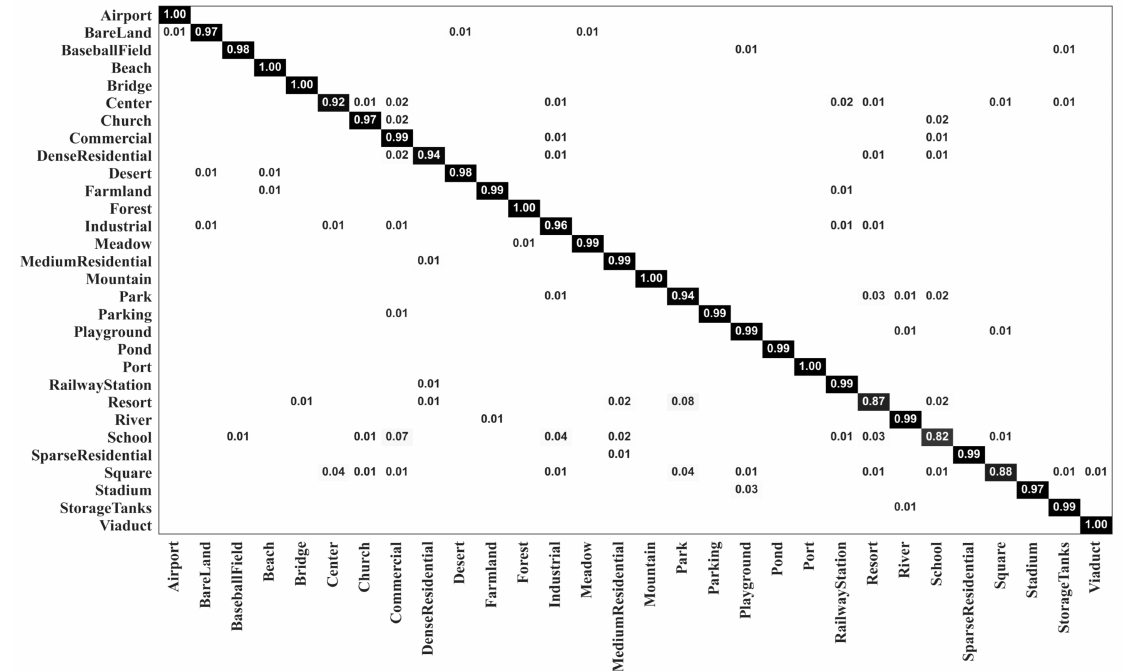
Figure 8. Confusion matrix of MopNet-GCN-ResNet50 on the AID dataset under a training ratio of